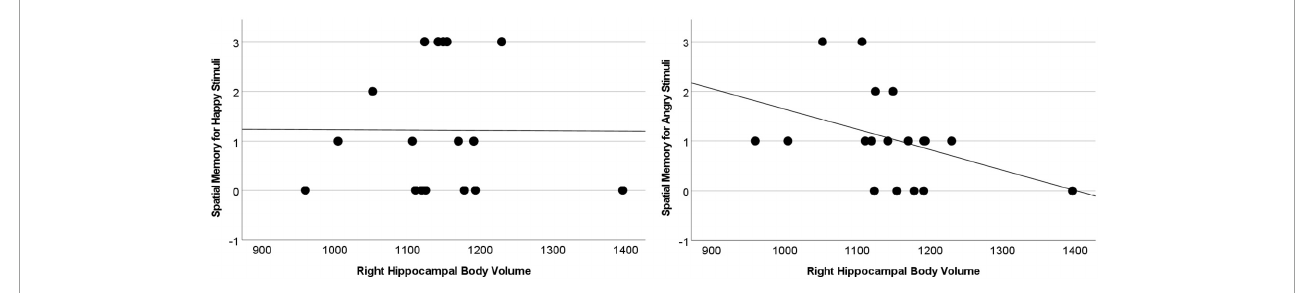
FIGURE3 Memory for the difference between Angry and Happy stimuli in the space condition associated with larger right hippocampal body volumes (Rho = 0.639, p = 0.004).